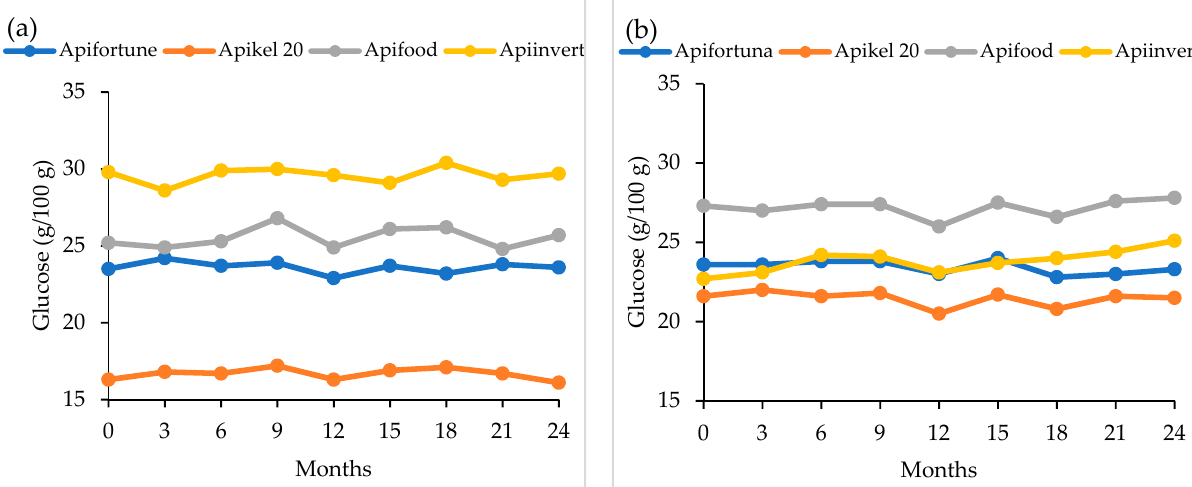
Figure 8. Changes of glucose content in syrups during storage at 10–14 °C ( a ) from 2012 and ( b ) from 2013.